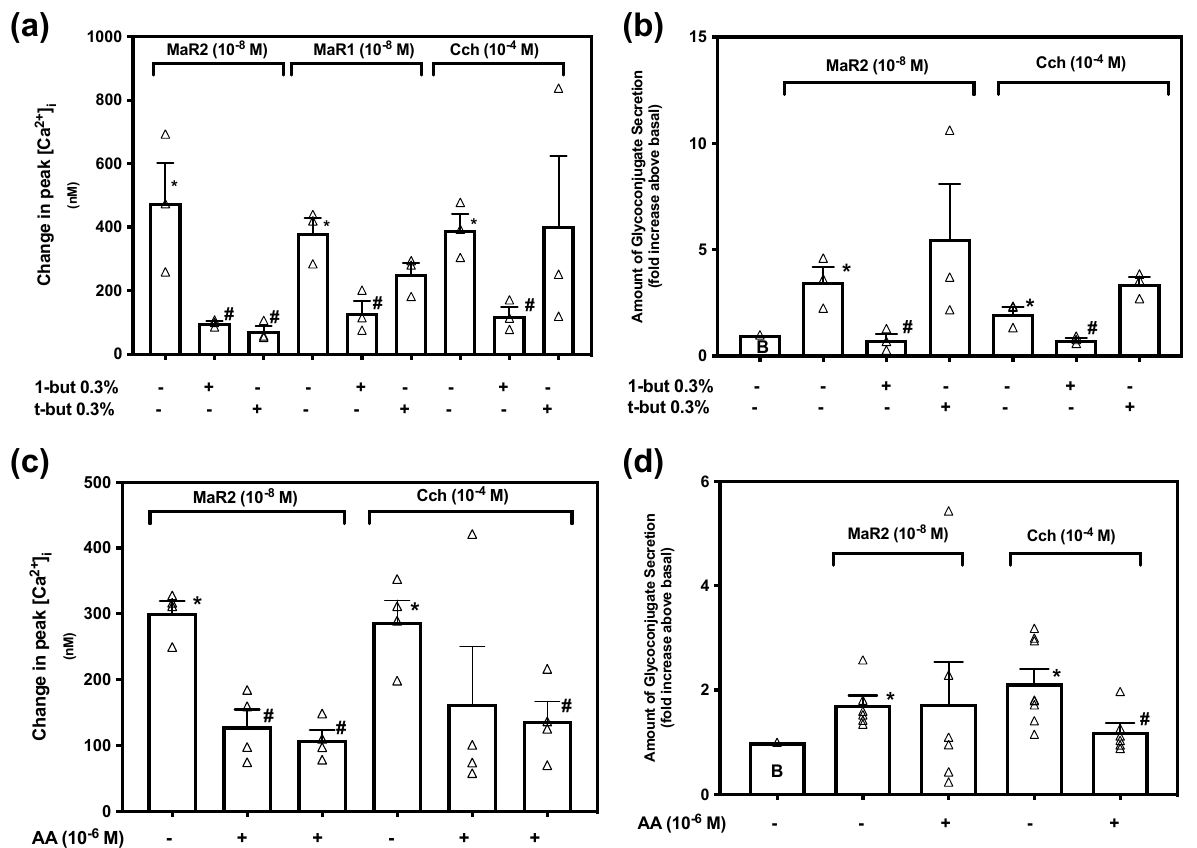
Figure 8. Maresin 2 has different dependency on Phospholipase D (PLD) compared to Phospholipase A 2 (PLA 2 ) to increase [ Ca 2+ ] i and stimulate secretion in rat conjunctival goblet cells. Goblet cells were preincubated with the PLD inhibitor 0.3% 1-butanol or the inactive analog 0.3% t-butanol for 15 min and then stimulated with MaR2 (10 − 8 M), MaR1 (10 − 8 M) or Cch (10 − 4 M) to measure the change in peak [ Ca 2+ ] i ( a ) , or secretion ( b ). Goblet cells were preincubated with the PLA 2 inhibitor aristolochic acid 10 − 5 M or 10 − 6 M for 30 min and stimulated with MaR2 (10 − 8 M) or Cch (10 − 4 M) to measure the change in peak [ Ca 2+ ] i ( c ), or secretion ( d ). Data are mean ± SEM of three ( a ), three ( b ), four ( c ) and six ( d ) experiments. White triangles indicate individual data points. * shows significance above basal. # shows significance between agonist and inhibitor followed by agonist.